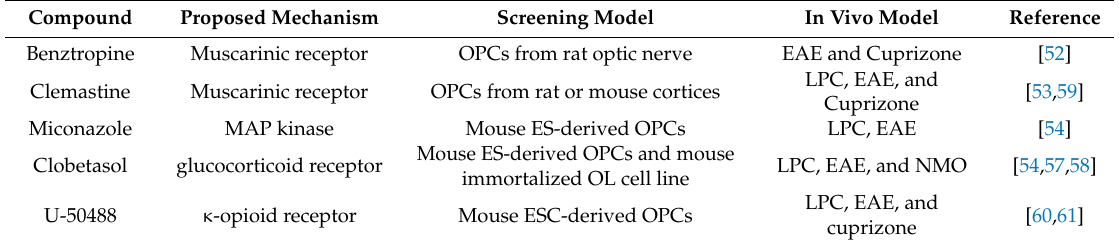
Table 2. Examples of studies using screening to identify potential therapy targets for